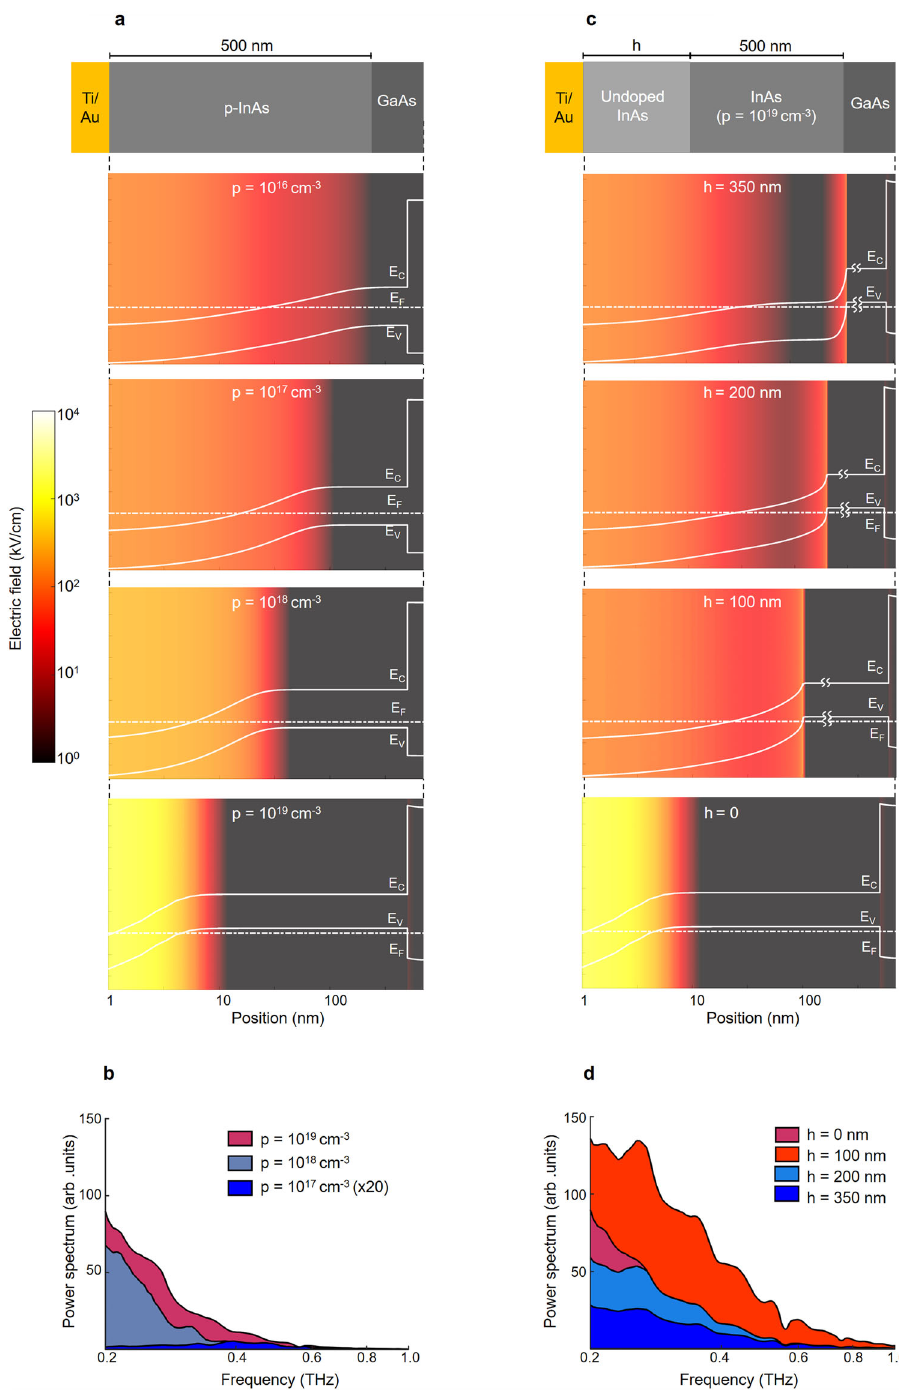
Fig. 3 Built-in electric fi eld pro fi le and its impact on the wavelength conversion ef fi ciency. a Band diagram of the p-doped InAs layer below the Ti/Au nanoantenna contact at different p-type doping concentrations are shown in white. The color map shows the strength of the built-in electric fi eld. A Sentaurus device simulator is used to generate the band diagram and built-in electric fi eld plots. The built-in electric fi eld drifts the high-mobility photo- generated electrons to the Ti/Au contact without any barrier height and sweeps away the low-mobility photo-generated holes from the Ti/Au contact. b The measured terahertz radiation spectra from identical nanoantenna arrays fabricated on three InAs substrates with the p-type doping concentrations of 10 17 , 10 18 , and 10 19 cm − 3 in response to the same optical pump beam. The radiation spectra are shown in a linear scale to clearly show the wavelength conversion ef fi ciency variations. c Band diagram and the built-in electric fi eld pro fi les; when an undoped InAs layer is incorporated between the p-doped InAs epilayer and the Ti/Au contact. d The measured terahertz radiation spectra from identical nanoantenna arrays fabricated on four InAs substrates with undoped InAs layer thicknesses of 0, 100, 200, and 350 nm grown on an InAs epilayer with a p-type doping of 10 19 cm − 3